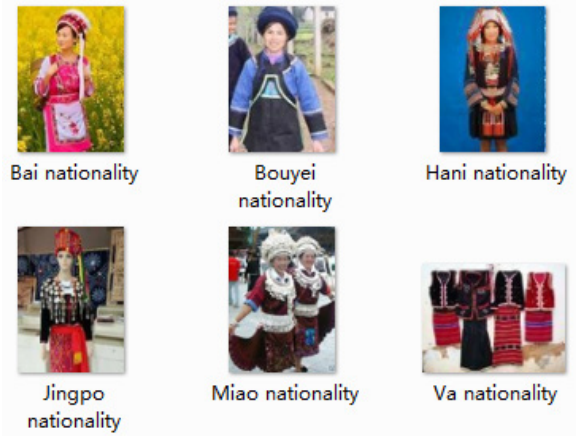
Fig.1. An example of the minority costume image